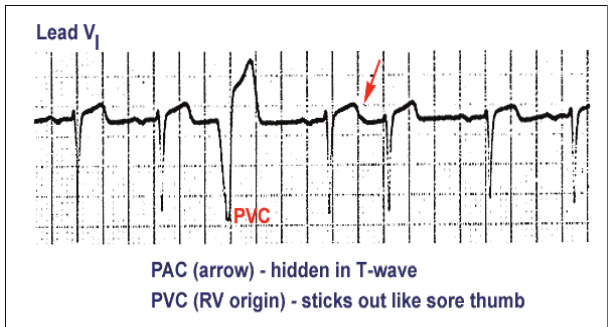
Source : Adapted from ECG Learning Center. Identification of PVC’s and PAC’s-KH. Available from: https://ecg.utah.edu/img/items/ecg_402.gif PAC, premature atrial contraction; PVC, premature ventricular contraction. FIGURE 3: Premature atrial contraction and premature ventricular